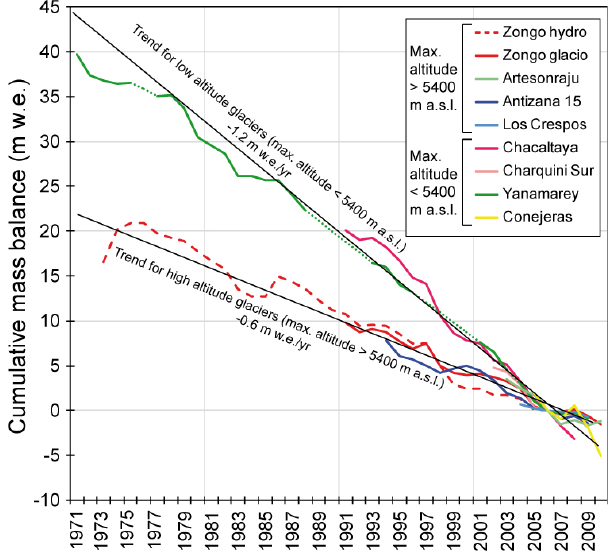
Fig. 6. Cumulative annual mass balance series computed for eight glaciers in the tropical Andes. 2006 was chosen as the common ref-